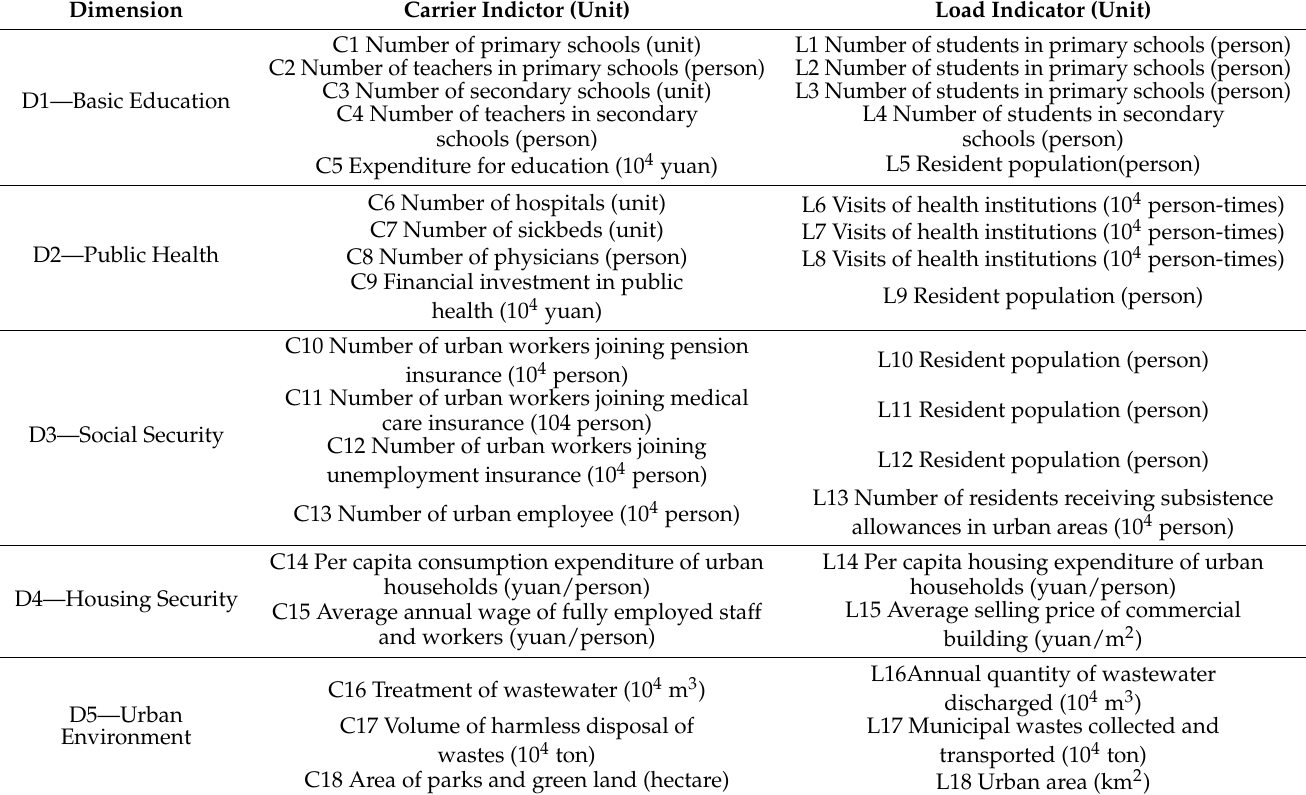
Table 4. UPSCC carriers and load indicators used in this